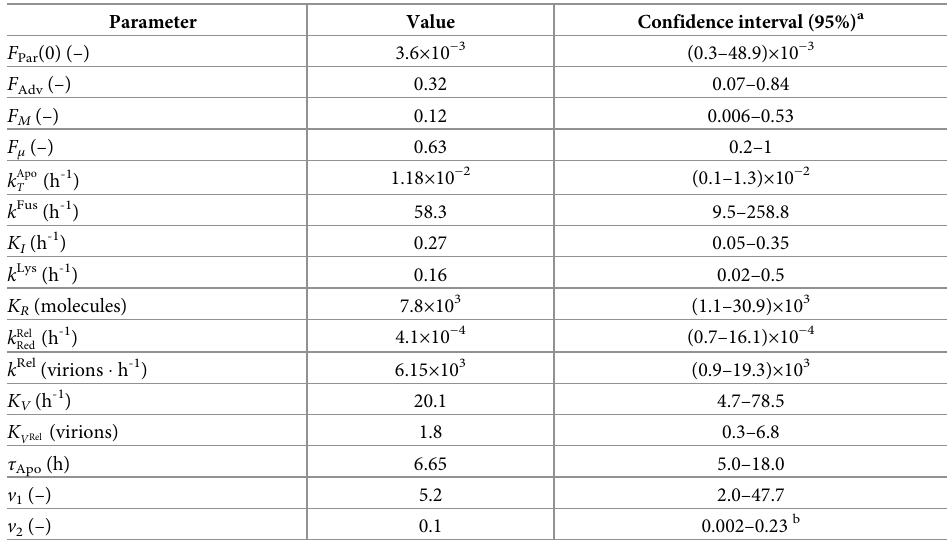
Table 1. Parameters estimated from the experimental data in S1 and S3–S10